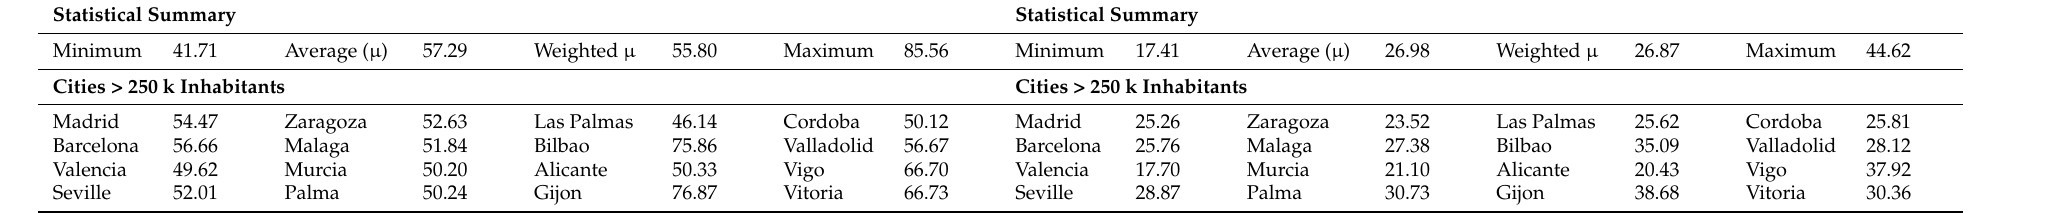
Figure 11. Ratio effort in emissions-energy production for PV ( left ) and ST ( right ) installations (in g CO 2 eq/kWh).